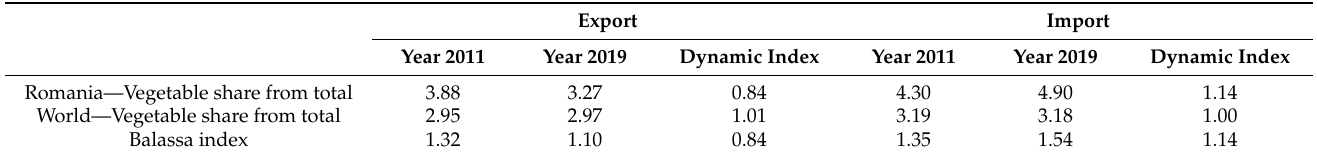
Table 6. Balassa index of export and import with